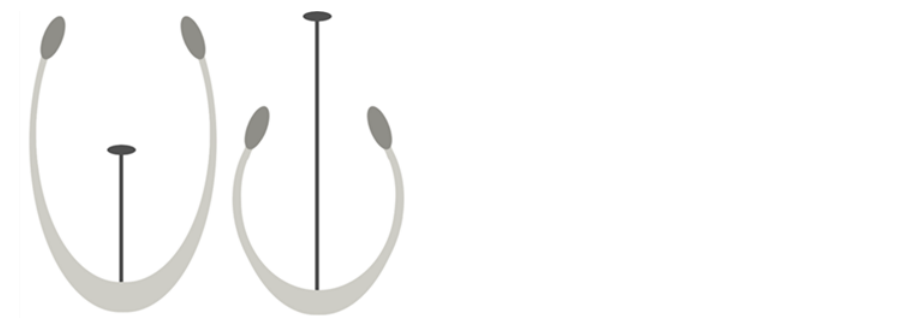
Figure 1. Representative diagram of the S-morph (left) and L-morph (right) in distylous Turnera